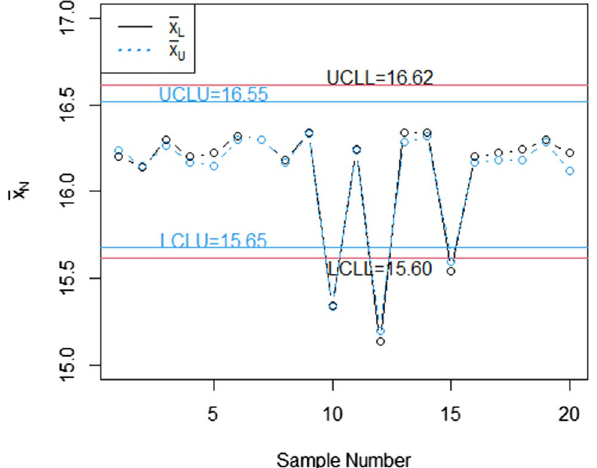
Fig. 6 The control chart proposed by [29] for real